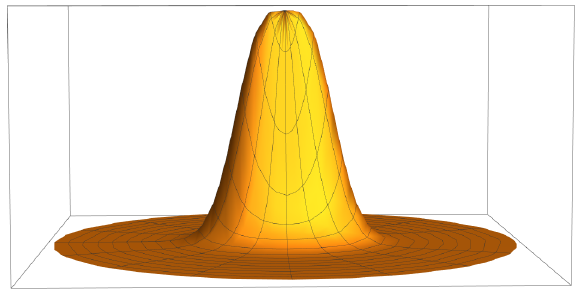
Figure 1. Positive representation of a complex